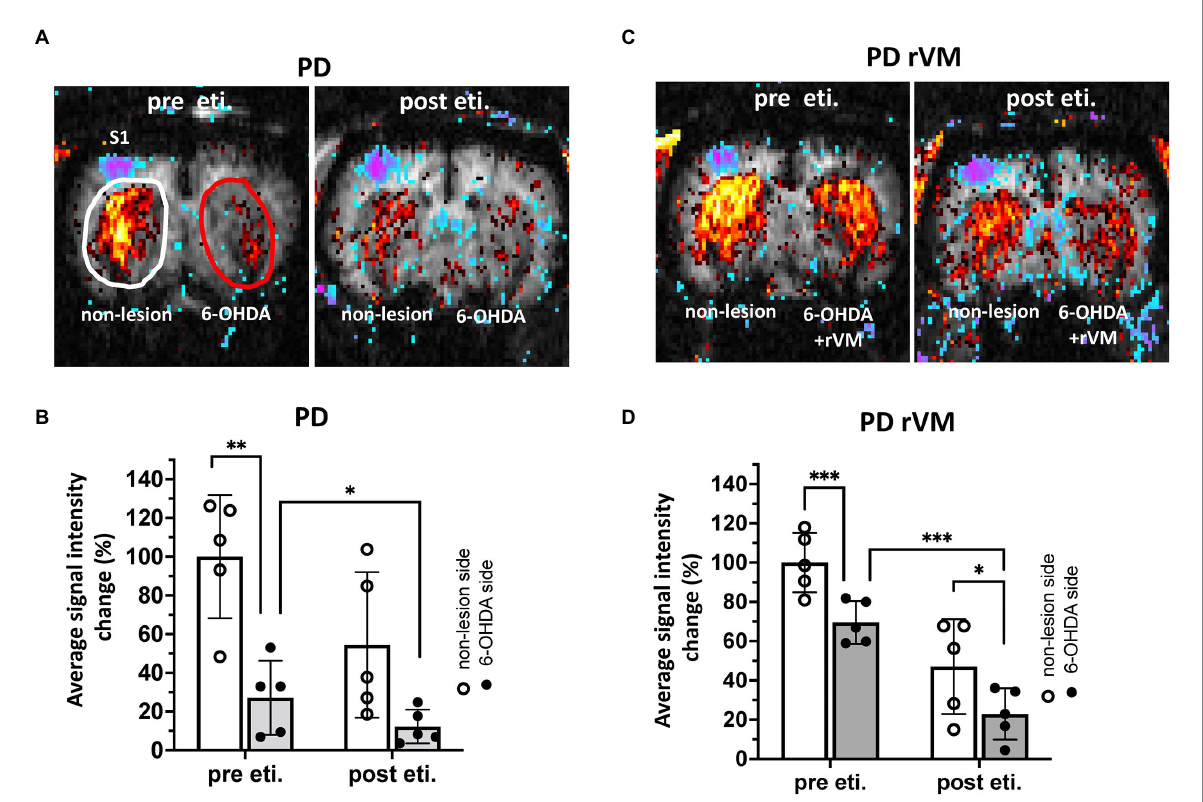
FIGURE 6 In vivo fMRI CBV signals in the striatum of 6-OHDA-lesioned PD rats. (A–C) The blue-purple signal in left primary somatosensory cortex (S1) where indicated as successful nociceptive electrical stimulation from right forepaw. Representative images of CBV signals was shown in the regions of interest, as white oval denotes non-lesion (left) side and red oval denotes the 6-OHDA side of the striatum. The quantitative results of in vivo fMRI CBV signals in 6-OHDA-lesioned PD rats. (B–D) Pre eticlopride: In the PD group, the CBV signal on the 6-OHDA-lesioned side was significantly reduced compared to the unlesioned side; however, cell transplantation in the PD-rVM group reduced this difference between the 6-OHDA- lesioned and unlesioned sides from 73 to 30%. (B–D) Post eticlopride: Eticlopride significantly reduced the CBV signals in both the PD and PD-rVM groups. * p < 0.05, ** p < 0.01 and *** p < 0.005.